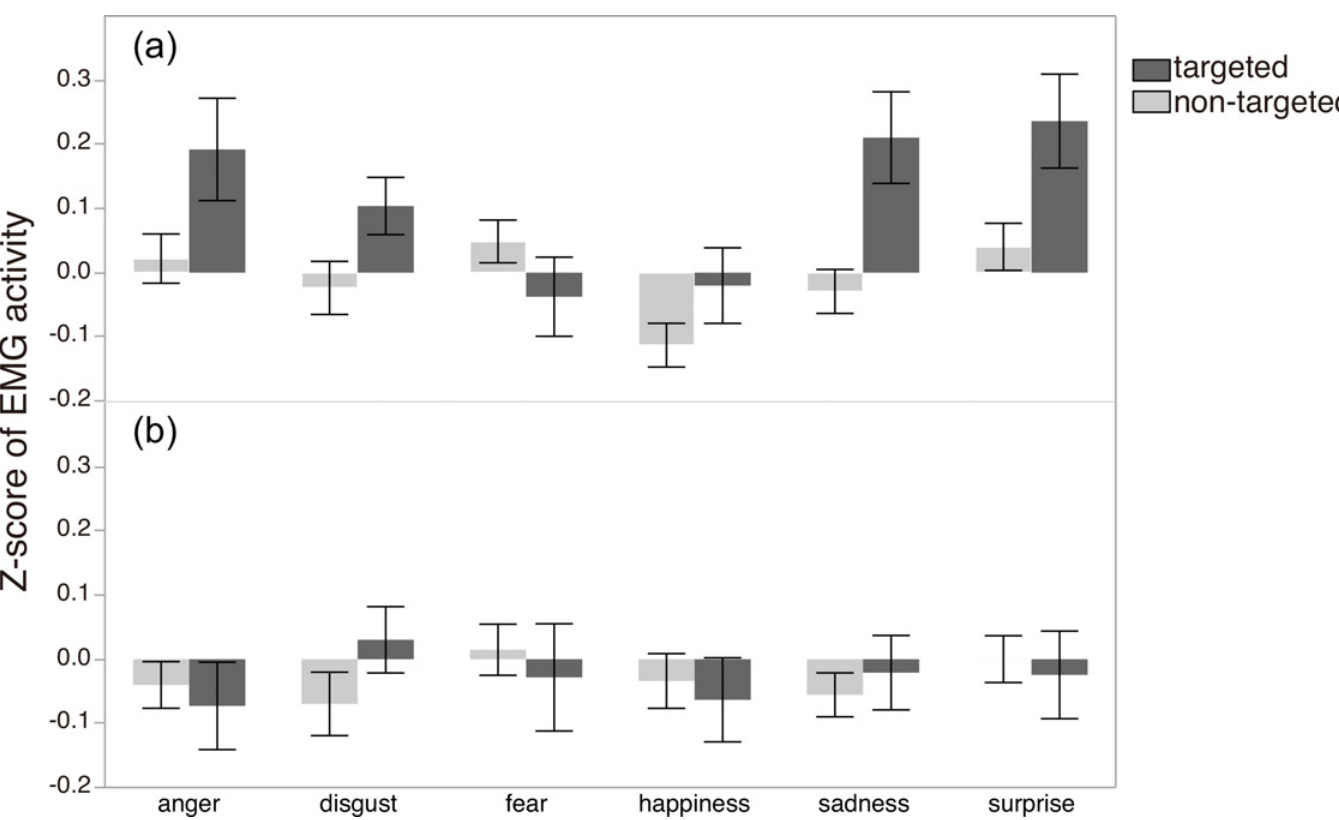
Fig 3. Z scores of EMG activity by emotion for each muscle type (targeted or non-targeted) in (a) the Emotion-Inference condition (N = 26) and (b) the Passive condition (N = 24) . Error bars represent standard error of the